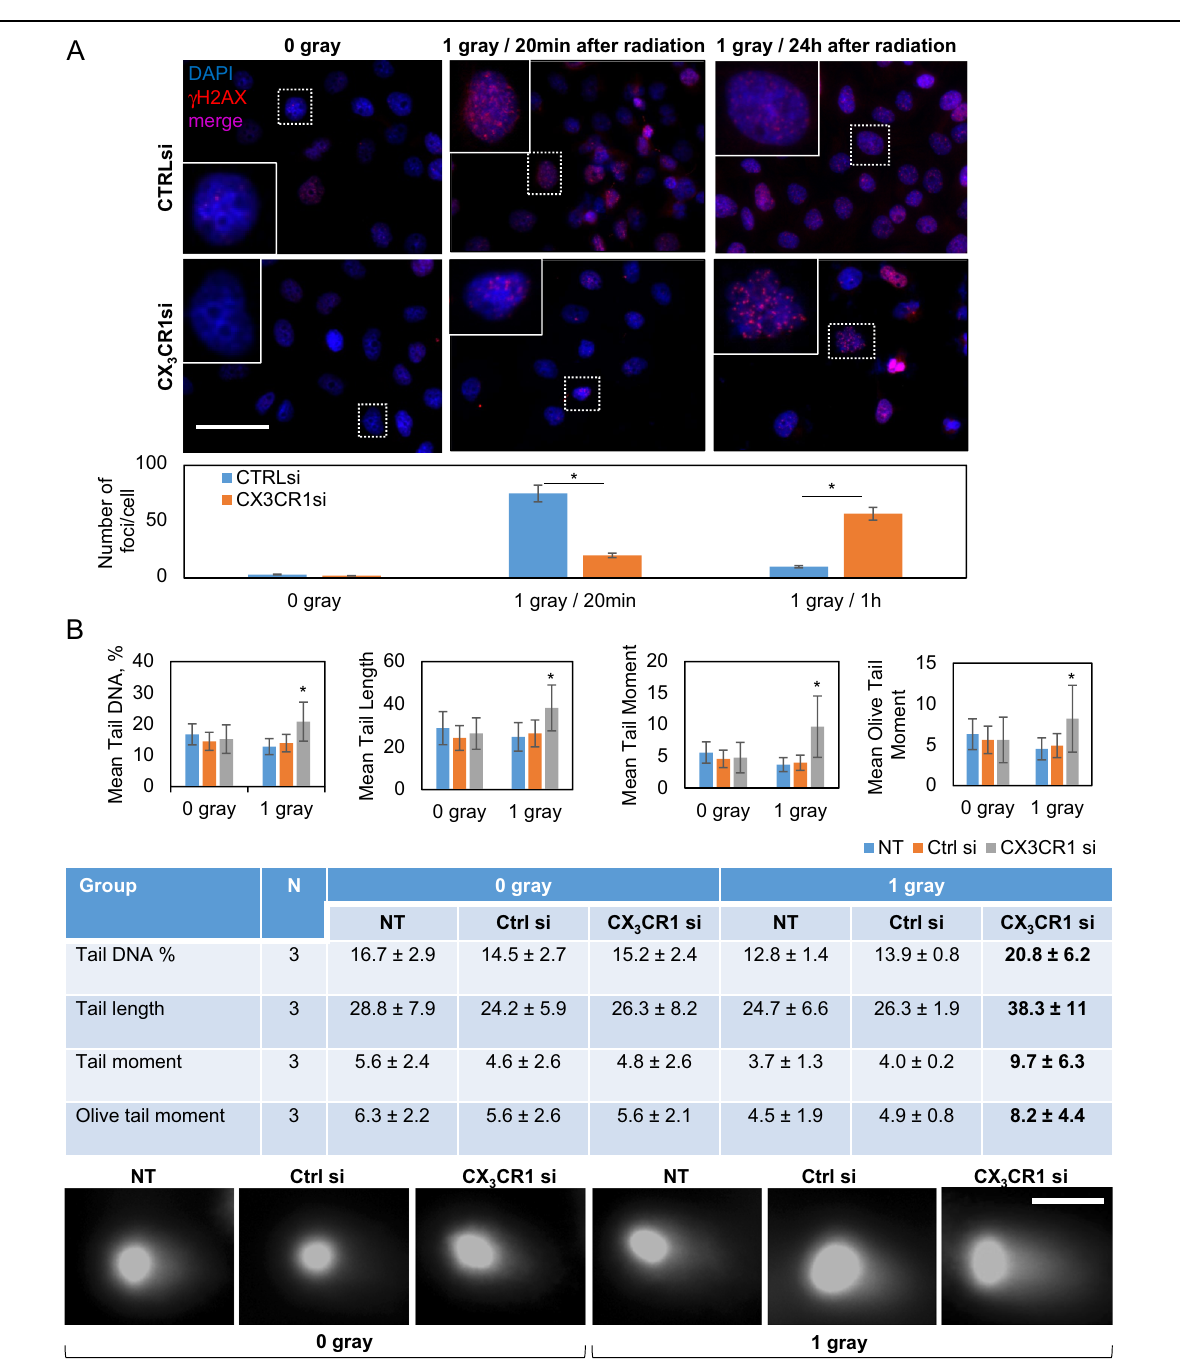
Fig. 3 Combination of CX 3 CR1 downregulation and x-ray radiation induces double-strand DNA breaks in HGSOC cell lines. OVCAR-4 was transiently transfected with either CX 3 CR1-speci fi c (designated “ CX 3 CR1si ” ), control (designated “ Ctrl si ” ), or vehicle (designated “ NT ” ) and subjected to 0 or 1 gray x-ray on the third day following transfection. a Cells were plated on glass cover slips either 20 min or 24 h after irradiation, as indicated, and stained with γ H2AX-speci fi c antibodies. Nuclear DNA was stained with 4 ′ ,6-diamino-2-phenylindole (DAPI). Images were superimposed from red and blue channels. Number of γ H2AX-positive foci (red fl uorescence) in three independent experiments was quanti fi ed using Zeiss Axiovert software and plotted. * p < 0.05, Student ’ s t test. Bar, 50 μ m. Nuclei outlined with dotted lines were enlarged and shown at corners of the corresponding images. b Alkaline comet assay was performed as detailed in Methods. Mean tail DNA (%), mean tail length, mean tail moment, and mean olive tail moment were quanti fi ed as an average from three independent experiments, plotted, and tabulated. * p < 0.05, one-way ANOVA and MANOVA tests. Immuno fl uorescence images (in black&white) show typical nuclei of cells in all tested conditions subjected to comet assay. Bar, 10 μ